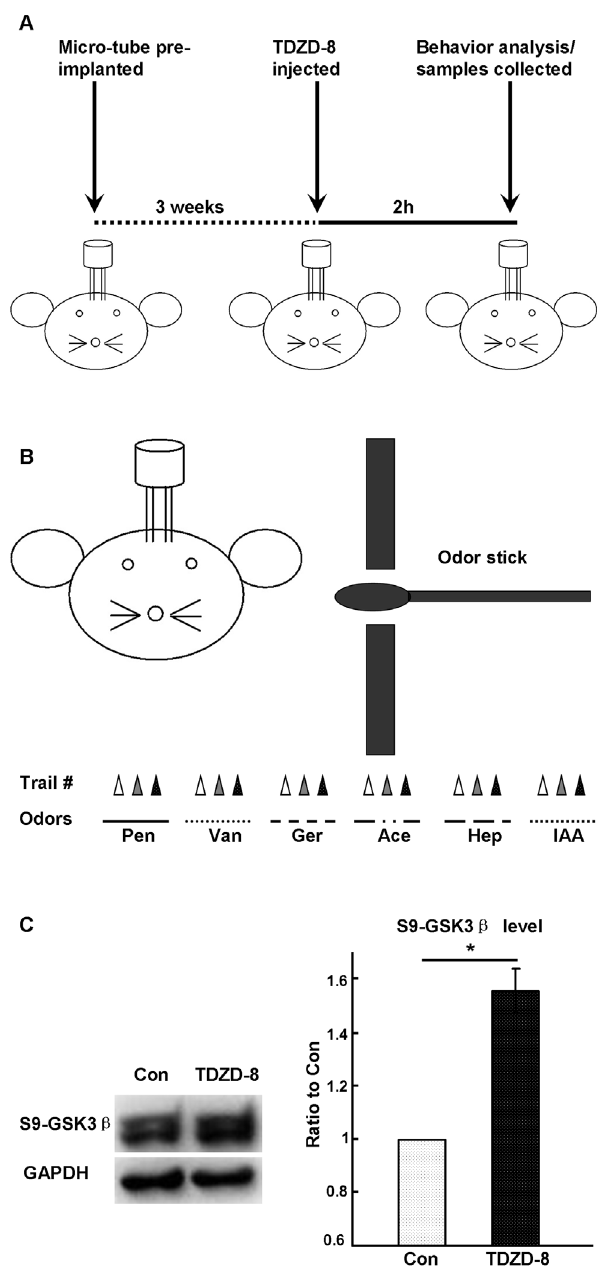
Figure 5. Scheme of the procedure for the animal behavior testing. The mice were bilaterally implanted with stainless steel cannulas into OB and allowed to recover for 3 weeks. Two hours before the behavioral testing, TDZD-8 or vehicle was delivered into the OB through the cannula (A), and the odor cross-habituation behavior analysis was performed following a standard protocol (B). C: S9-GSK3 b was significantly up-regulated in the OBs of TDZD-8-treated mice (n=8, P , 0.05). (n-pentanol, Pen; vanillin, Van; geranialdehyde, Ger; aceto- phenone, Ace; Heptanone, Hep; Isoamyl Acetate, IAA). * P , 0.05. The data shown are the average 6